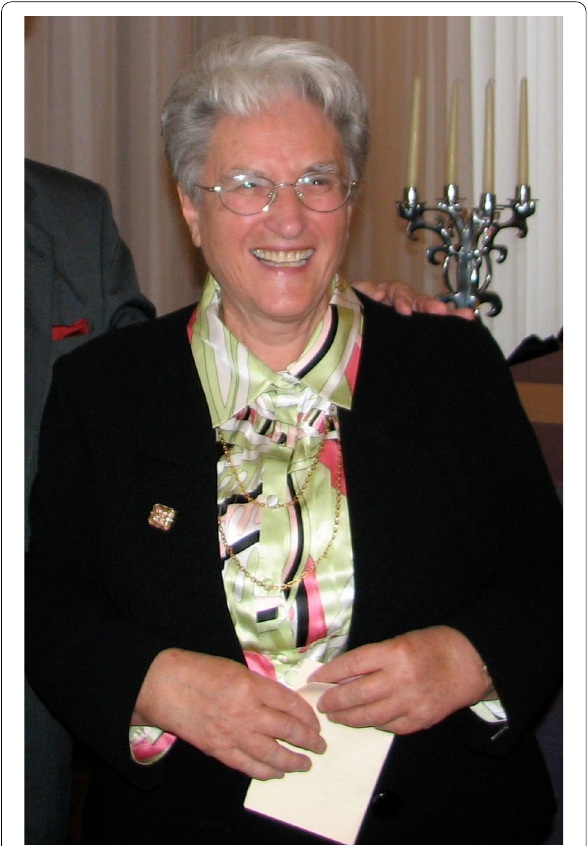
Fig. 16 Marie-Agnès Letrouit-Galinou when awarded the Légion d’Honneur on 30 September 2008. Photo: